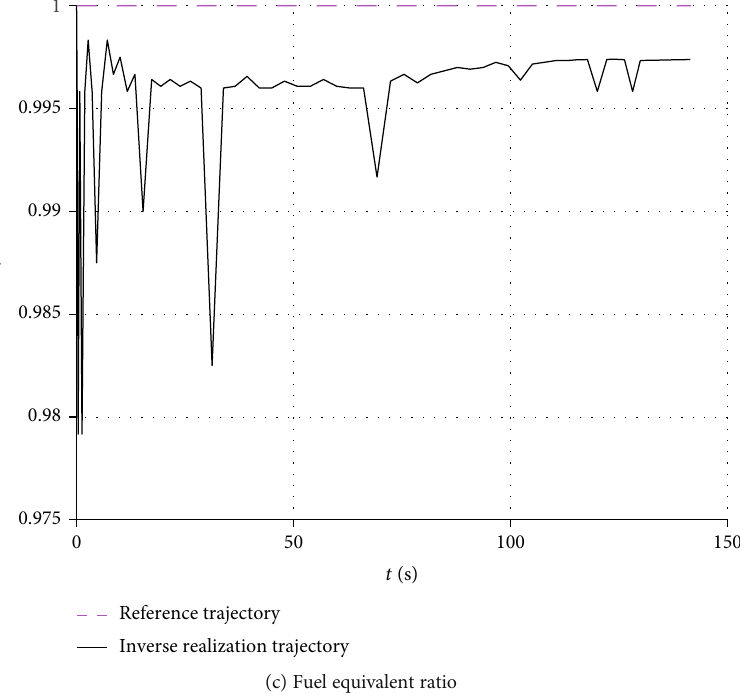
Figure 8: Control variables obtained by trajectory inverse